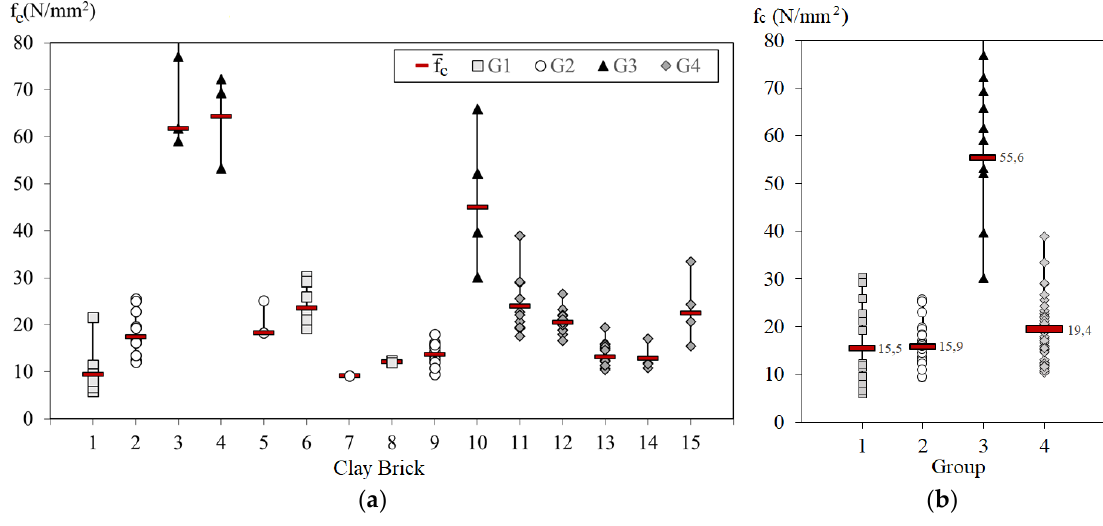
Figure 6. Compressive strength of ( a ) clay bricks and ( b ) groups.